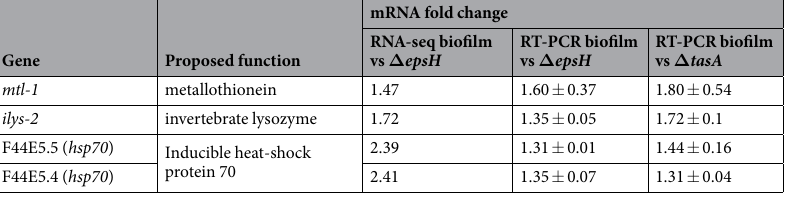
Table 1. Induction of biofilm-responsive genes in C. elegans . The table shows a list of genes whose expression changed (q-value < 0.05) in C. elegans fed biofilm-forming B. subtilis NCBI3610 (biofilm) compared to biofilm-deficient B. subtilis ( Δ epsH ) at day 5 of adulthood, validated by RT-PCR. To calculate the fold change, the expression level of each gene in C. elegans fed B. subtilis Δ epsH or Δ tasA was taken as 1. For RNA-seq, three independent biological replicates were processed (see Materials and Methods). Expression analysis with RT-PCR was performed in three independent biological replicates and the mean value of fold change ± SE is